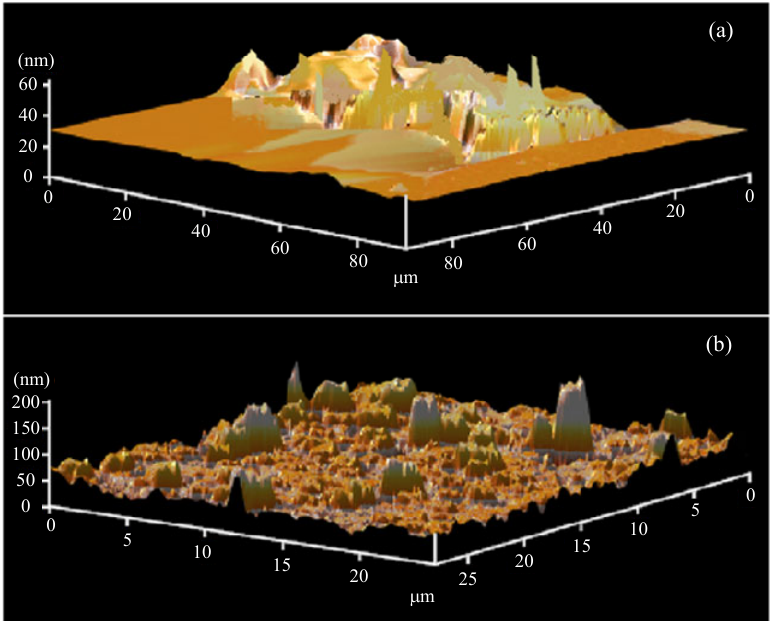
Fig. 4 3D AFM images of (a) region deposited with Au-Fe 2 H 2 O 4 and a bare region on the same glass slide and (b) surface roughness of the Fe 2 H 2 O 4 deposited